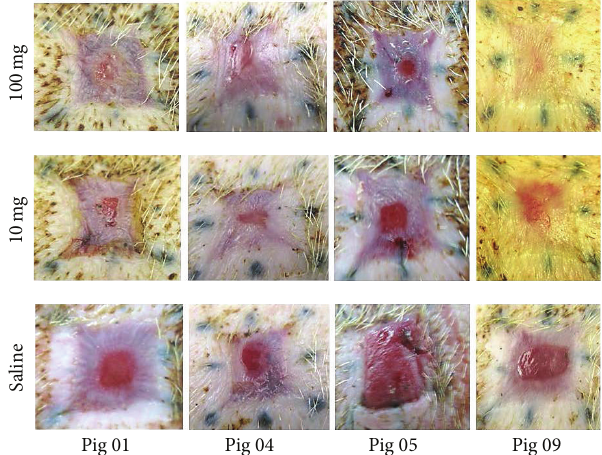
Figure 6: Healing of excisional wounds in the skin of GT-KO pigs treated with 𝛼 -gal nanoparticles or with saline and viewed on day 13. The original size of the wounds was 20 × 20 mm and 3 mm deep. The border of wounds was marked by tattooed dots to determine contraction during healing. Control wounds treated with saline display partial regeneration of the epidermis as a result of physiologic healing. However, wounds treated with 100 mg 𝛼 - gal nanoparticles are almost completely or completely covered with regenerating epidermis. Wounds treated with 10mg 𝛼 -gal nanopar- ticles heal faster than saline treated wounds, however, somewhat slower than wounds treated with 100mg 𝛼 -gal nanoparticles in the same pig. There are no significant differences of wound contractions between saline treated and 𝛼 -gal nanoparticles treated wounds. Modified from